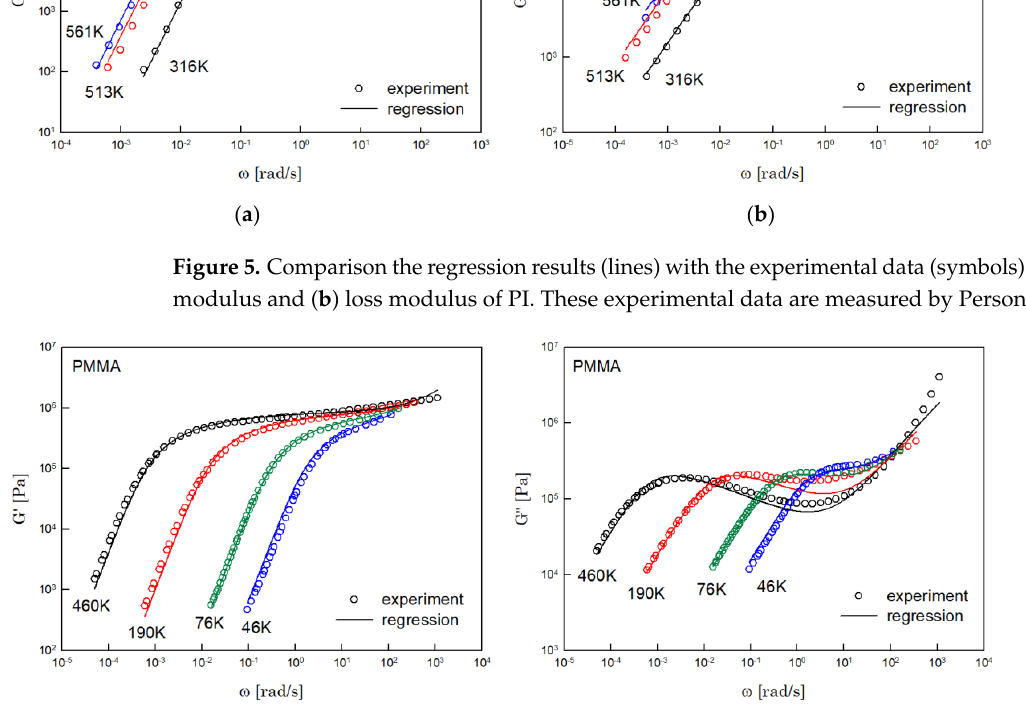
Figure 6. Comparison the regression results (lines) with the experimental data (symbols) of ( a ) storage modulus and ( b ) loss modulus of PMMA. These experimental data are measured by Fuchs et al. [18].